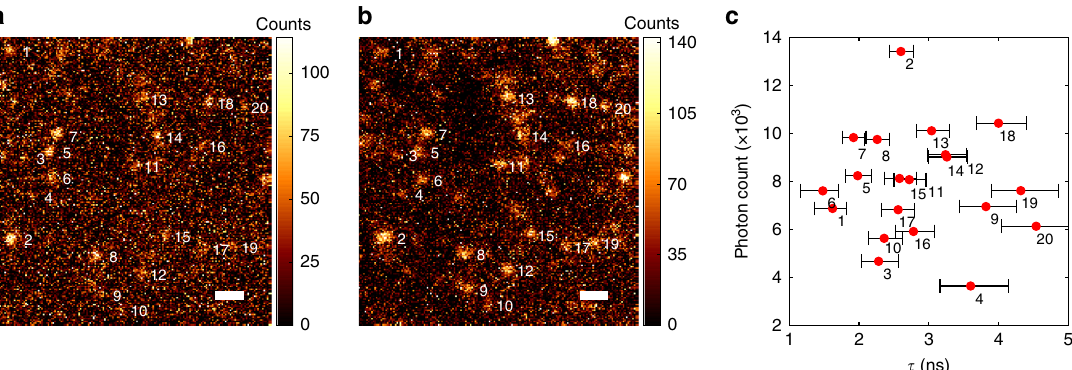
Fig. 3 Wide- fi eld FLIM of Alexa Fluor 532 molecules. a Gated channel intensity. b Ungated channel intensity (scale bar 1 μ m). c Measured lifetimes are plotted along with total brightness for the numbered, diffraction-limited regions with SE error bars indicated. The majority of these spots are single- molecule emitters as demonstrated by their photobleaching and blinking dynamics (Supplementary Figs. 4 and 5). Source data are provided as a source data fi le